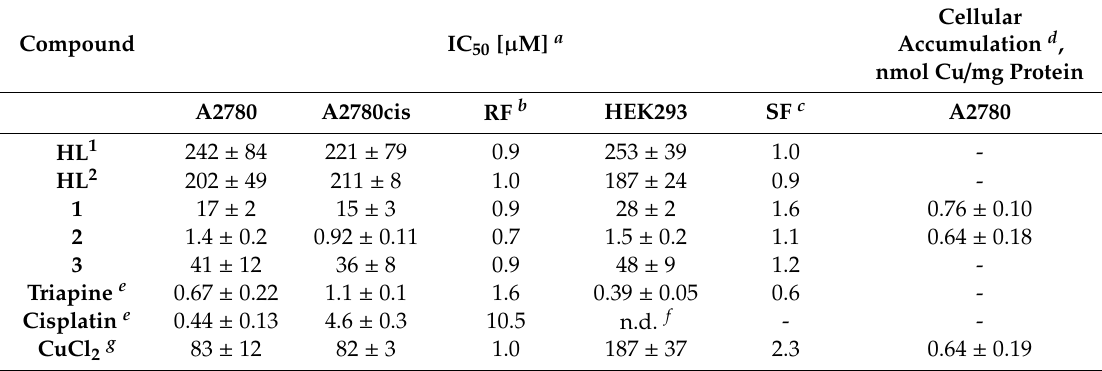
Table 2. Cytotoxicity of HL 1 and HL 2 , Cu(II) complexes 1 and 2 , and Fe(III) complex 3 . Compound IC 50 [ μ M] a